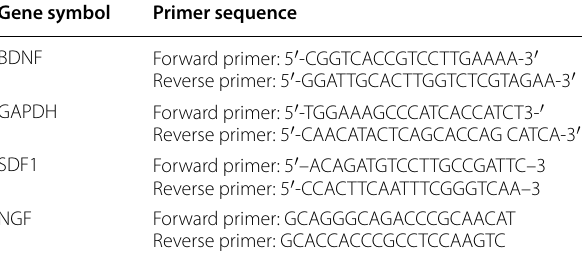
Table 1 Primers sequences used for qRT-PCR Gene symbol Primer